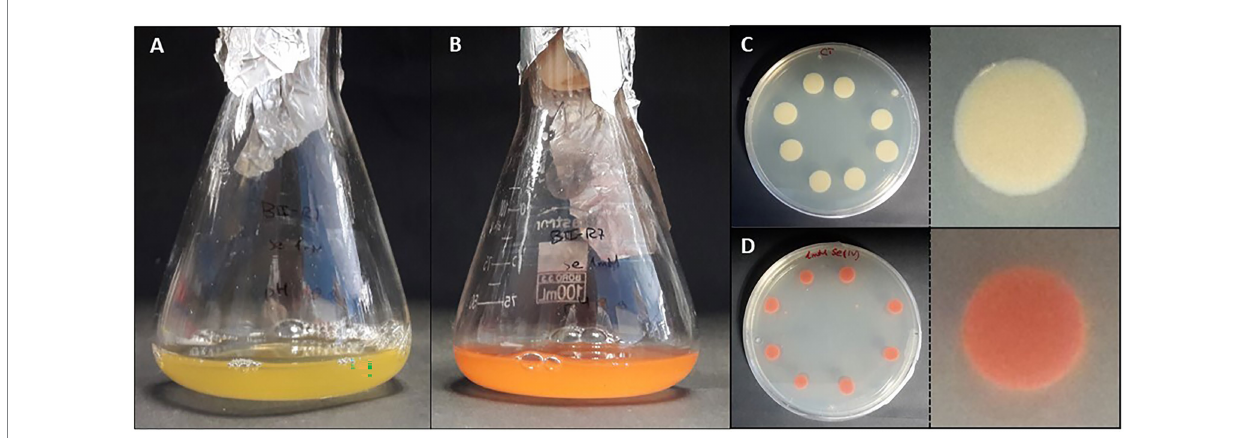
FIGURE 5 Colorful transition of liquid (A,B) and solid (C,D) cultures of the bacterium Stenotrophomonas bentonitica to red Se 0 when Se IV is added (personal archive of Dr. Merroun).